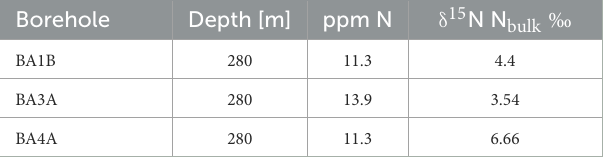
TABLE 7 Bulk rock δ 15N of peridotites sampled at the 280-m depth interval in boreholes BA1B, BA3A, and BA4A.